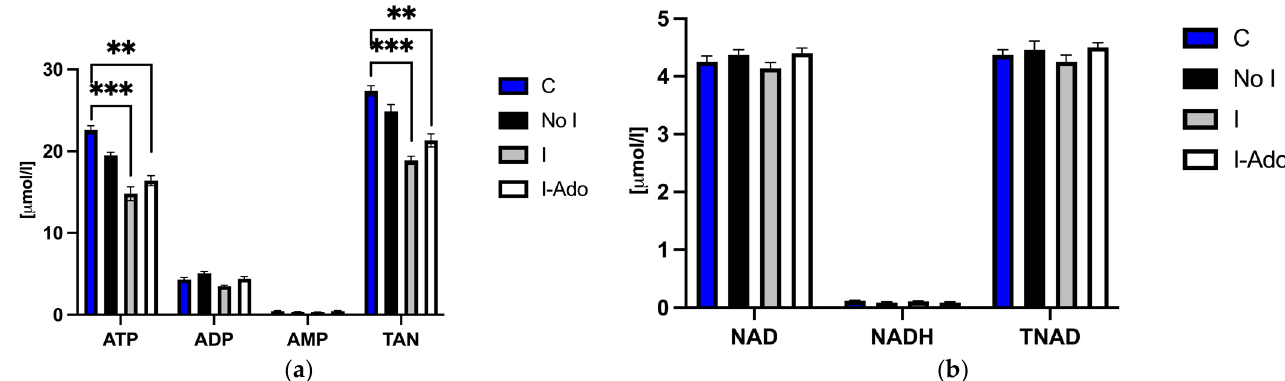
Figure 2. ( a ) ATP, ADP, AMP, and TAN and ( b ) NAD, NADH, and TNAD before, during, and after 1 min ischemia in hearts subjected to 1 min ischemia at 40 min of perfusion, 10 min ischemia at 50 min of perfusion, and 1 min ischemia at 85 min of perfusion without (Group I) or with (Group I-Ado) supply of adenosine at 30 µM concentration during the first 15 min of reperfusion and in control hearts (Group No I) subjected three times to 1 min ischemia at 40, 50, and 85 min of perfusion. For the initial values, control hearts (Group C) were perfused for 20 min. Values are mean ± SEM ( n = 5–9). ** p < 0.01, *** p < 0.005.